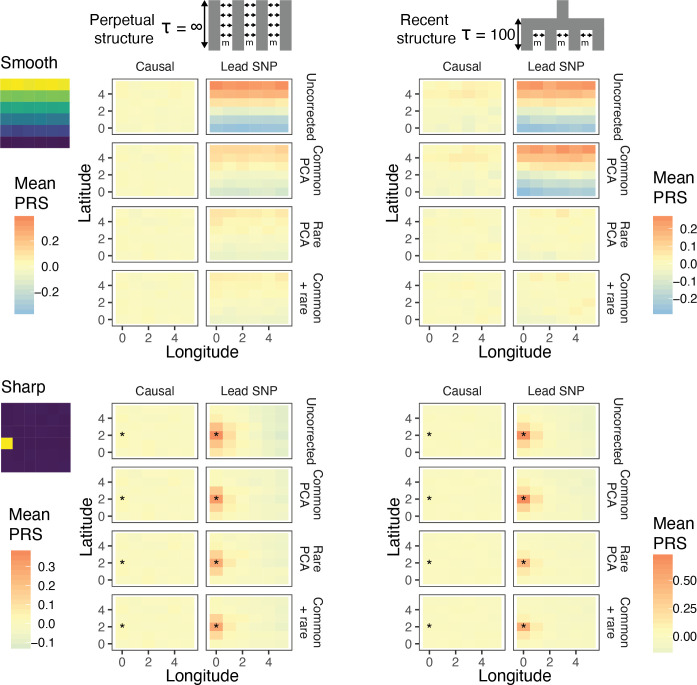
Residual stratification in effect size estimates translates to residual stratification in polygenic score in the (A) recent and (B) perpetual structure models.The simulated phenotype in the training sample has a heritability of 0.8, distributed over 2,000 causal variants. Each small square is colored with the mean residual polygenic score for that deme in the test sample, averaged over 20 independent simulations of the phenotype. In each panel, the rows represent different methods of PCA correction and columns represent two different methods of variant ascertainment. ‘Causal’ refers to causal variants with p-value < 5×10−4, and ‘Lead SNP’ refers to a set of variants, where each represents the most significantly associated SNP with a p-value < 5×10−4 in a 100 kb window around the causal variant. The simulated environment is shown on the left. For the sharp effect, the affected deme is highlighted with an asterisk.